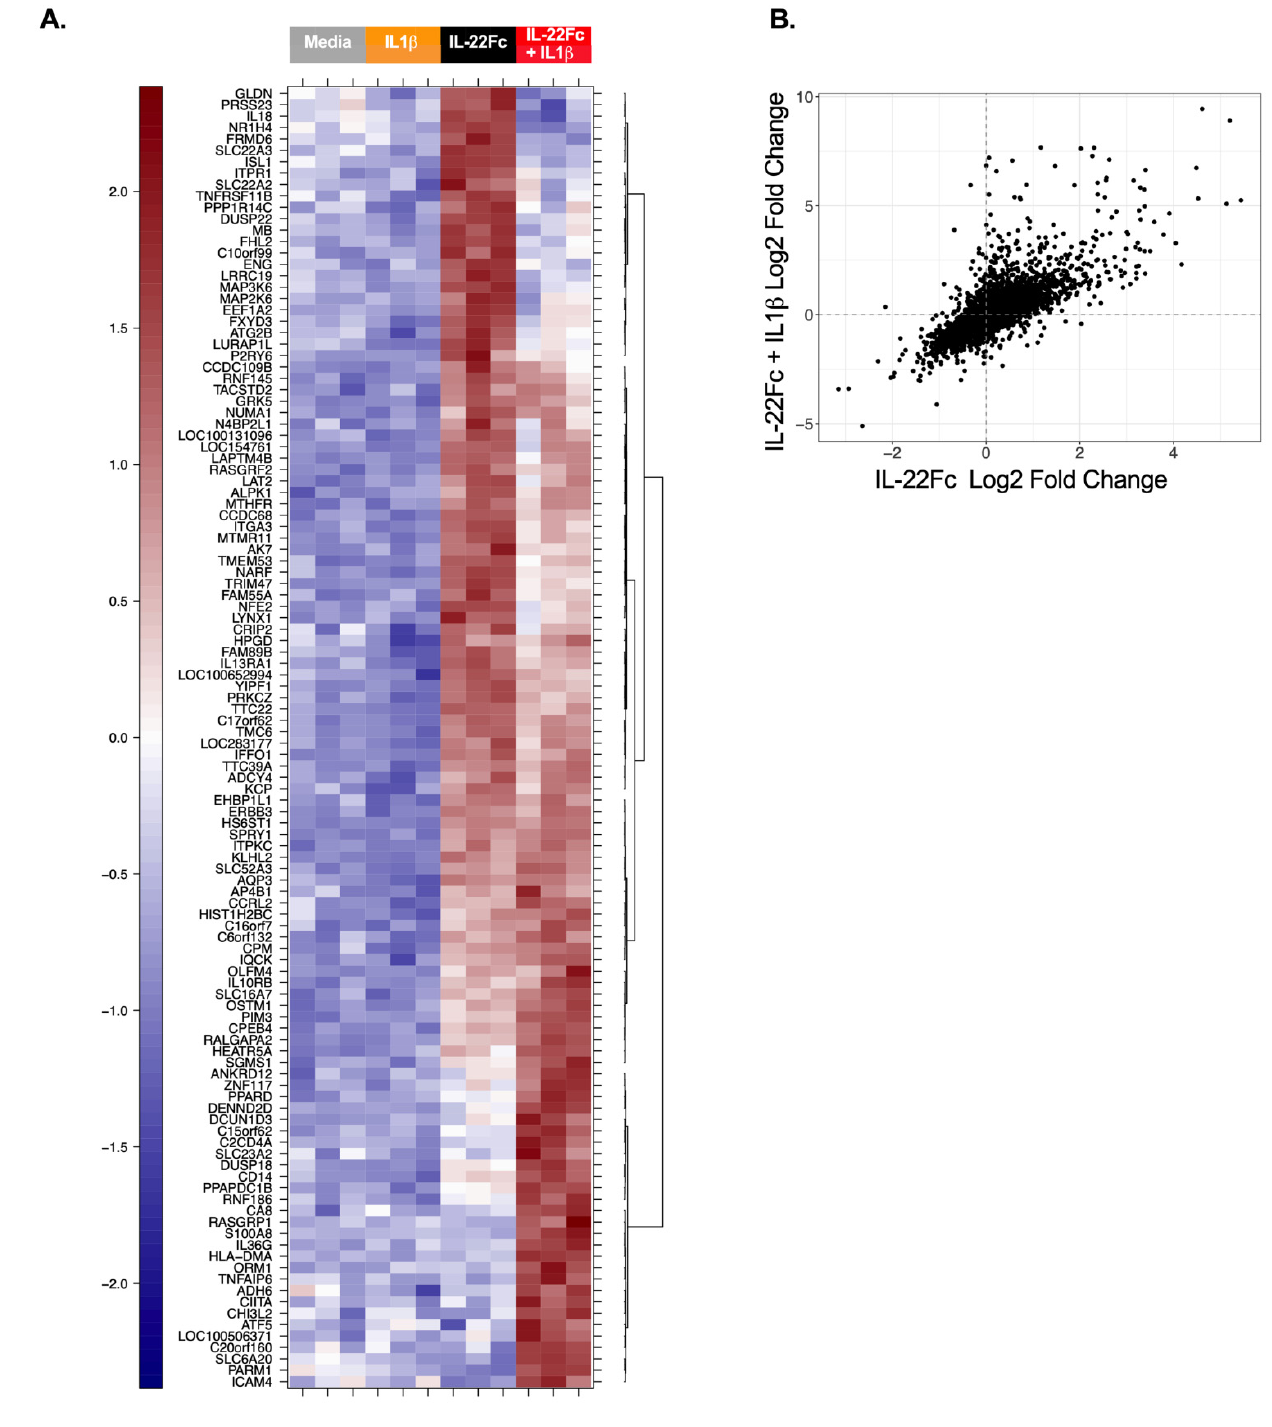
Figure 3. Differential gene expression by IL-22 in the presence of IL-1 β . ( A ) Heat map with the microarray gene expression from HT-29 cells cultured for 24 h with or without IL-1 β , IL-22Fc or IL-22Fc + IL-1 β prior to the RNA isolation. Three biological replicates are represented. ( B ) Scatterplot showing the genes upregulated by IL-22 alone vs. IL-22 + IL-1 β .